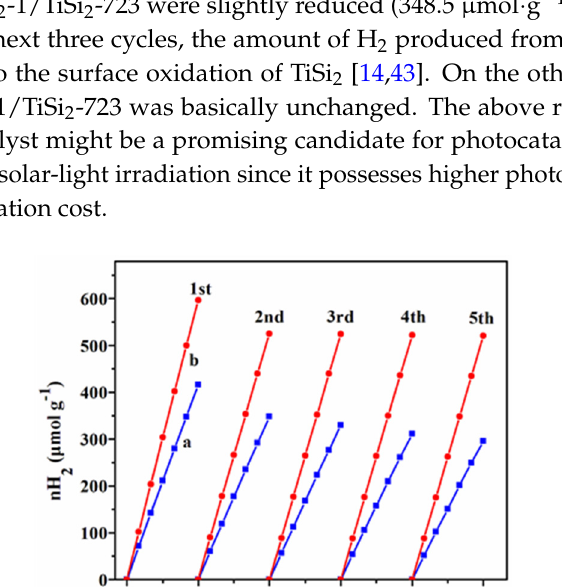
Figure 7. ( A ) The H 2 evolution rates of WS 2 ‐ 1/TiSi 2 ‐ y catalysts prepared at different temperatures; ( B ) the hydrogen production of TiSi 2 , WS 2 ‐ x /TiSi 2 ‐ 723, and Pt ‐ 1/TiSi 2 catalysts over 6 h. Reaction conditions: 50 mg catalysts, 60 mL 0.005 M oxalic acid aqueous solution, irradiation source: a 150 W Xe lamp equipped with a cut ‐ off filter at 420 nm.